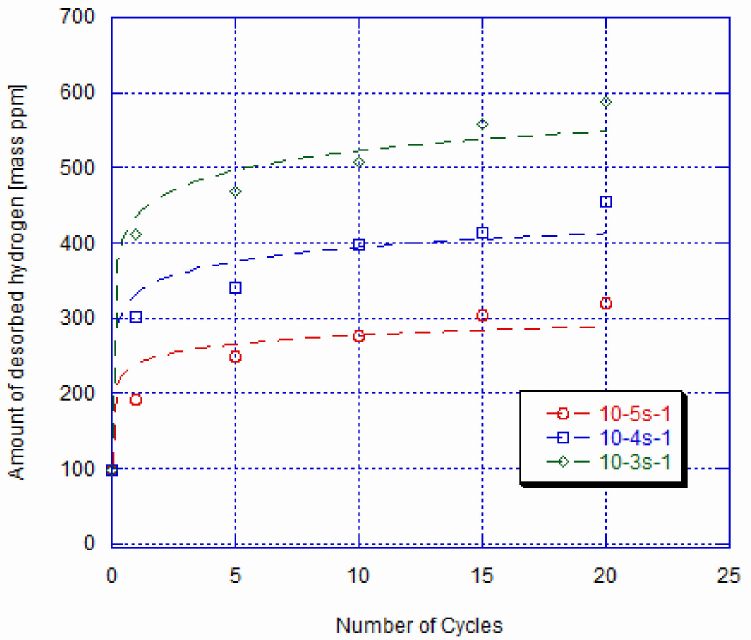
Figure 8. Amount of absorbed hydrogen vs. number of cycles of loaded and unloaded specimens at imposed 10 − 5 s − 1 , 10 − 4 s − 1 , and 10 − 3 s − 1 strain rates and hydrogen charging for 3 h (represents the fitting curve).